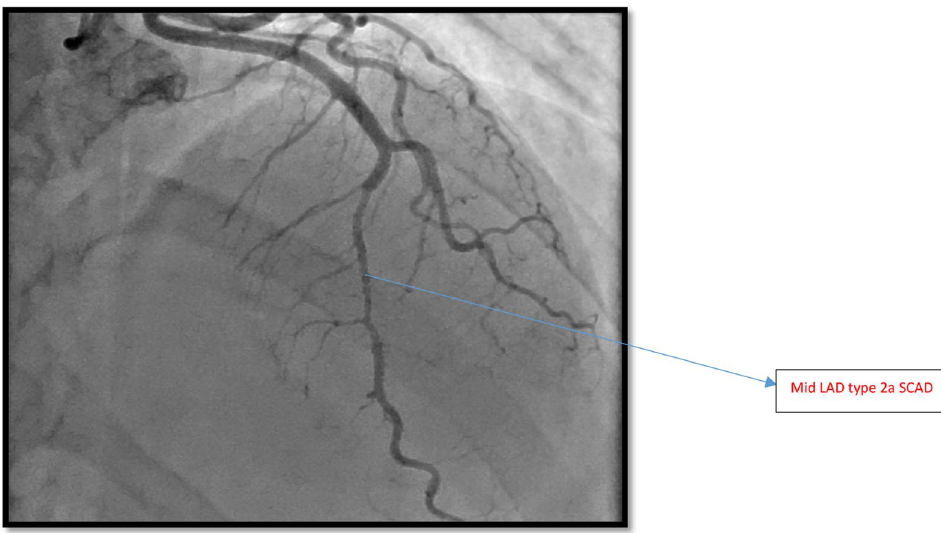
Fig. 7 Mid LAD Type 2a SCAD—Case 2 (Courtesy Dr Riley Batchelor